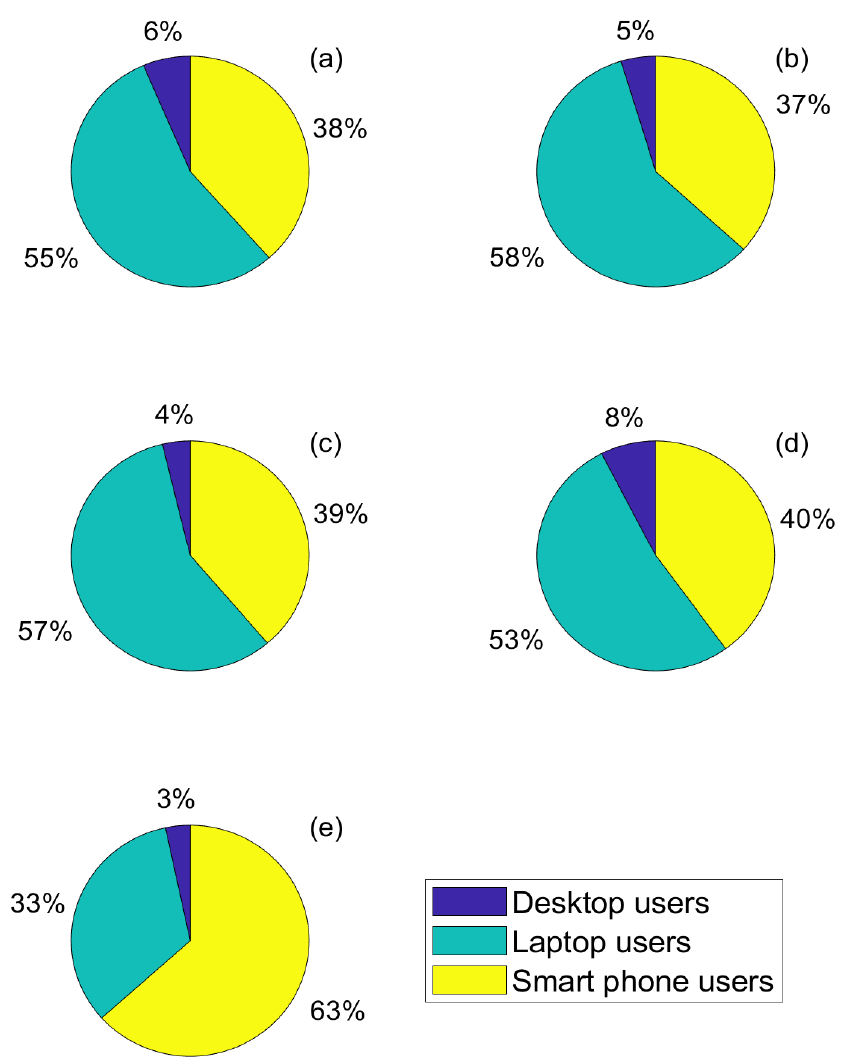
Figure 3. Devices used by students in Schools: ( a ) Engineering, ( b ) Technology, ( c ) Business, ( d ) IT and ( e ) Music. Note, percentage shown in each figure is rounded to nearest whole number and hence the total may or may not be equal to 100%.